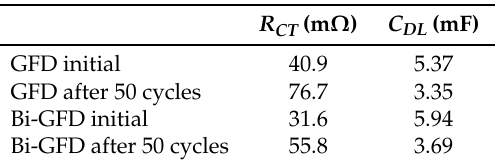
Figure 3. Results of charge/discharge cycling in a battery test system: ( a ) energy efficiency; ( b ) capacity over 50 cycles of charging and discharging at 100 mAcm − 2 ; ( c ) full cell EIS data before and after cycling. Table 1. Full Cell EIS parameters before and after 50 charge/discharge cycles at 100mA/cm 2 . Values for C DL were obtained by conversion of CPE parameters following Hirschorn et al.